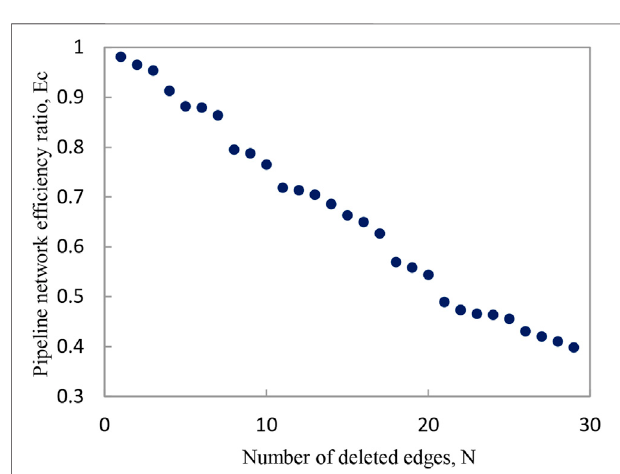
FIGURE 13 | The diagram of pipeline network ef fi ciency